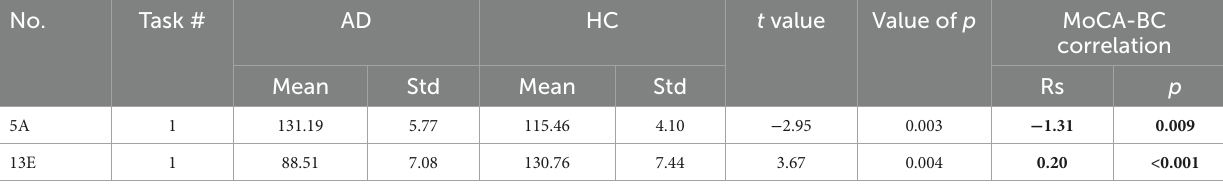
TABLE 3 Student’s t -test summary (only parameters with p < 0.05).